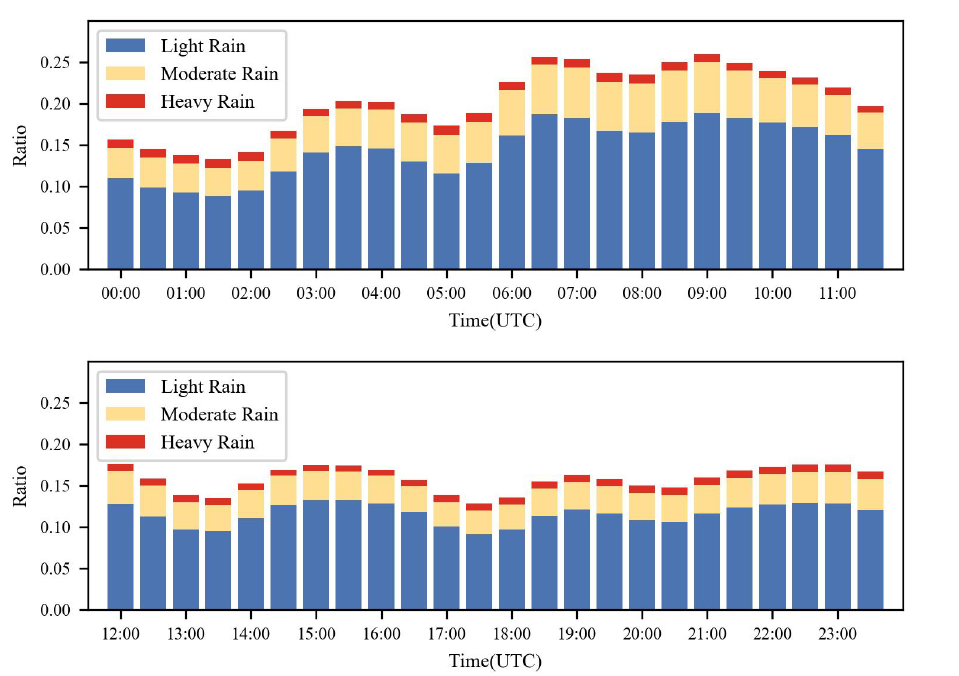
Figure 3. The trend of the ratio of Rain samples over time. The Rain samples rise in fluctuation from 00:00 to 11:30 and decrease in fluctuation from 12:00 to 23:30.